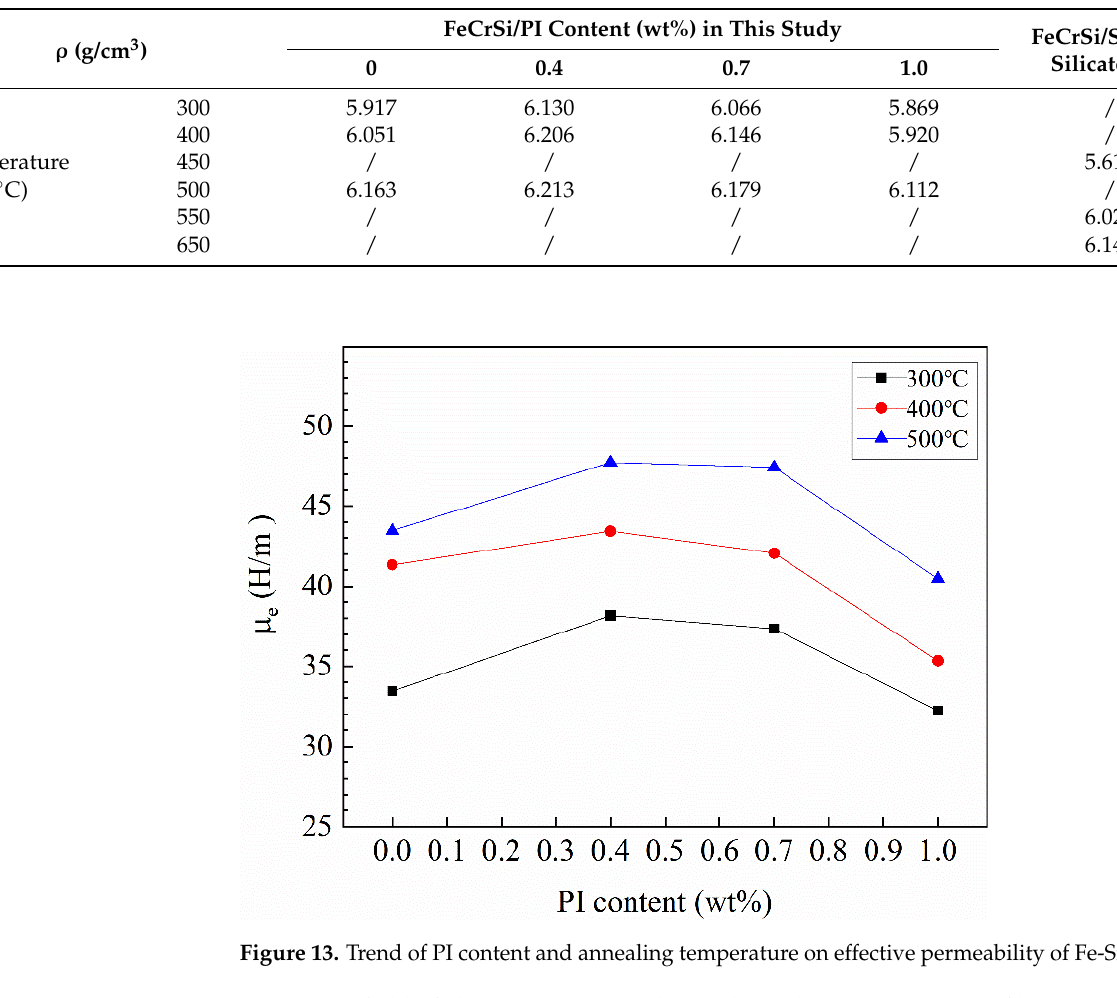
Table 1. Density tests of Fe-Si-Cr SMCs coated with various content of PI at different annealing temperatures.